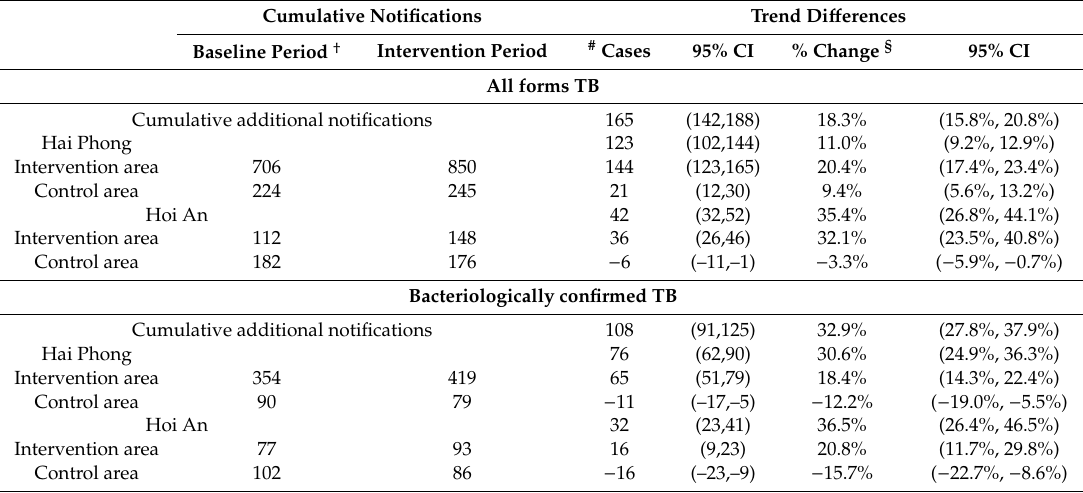
Table 3. Impact analysis [24] of all forms and bacteriologically confirmed TB notifications by city. Hai Phong and Quang Nam, Viet Nam. January 2018 to March